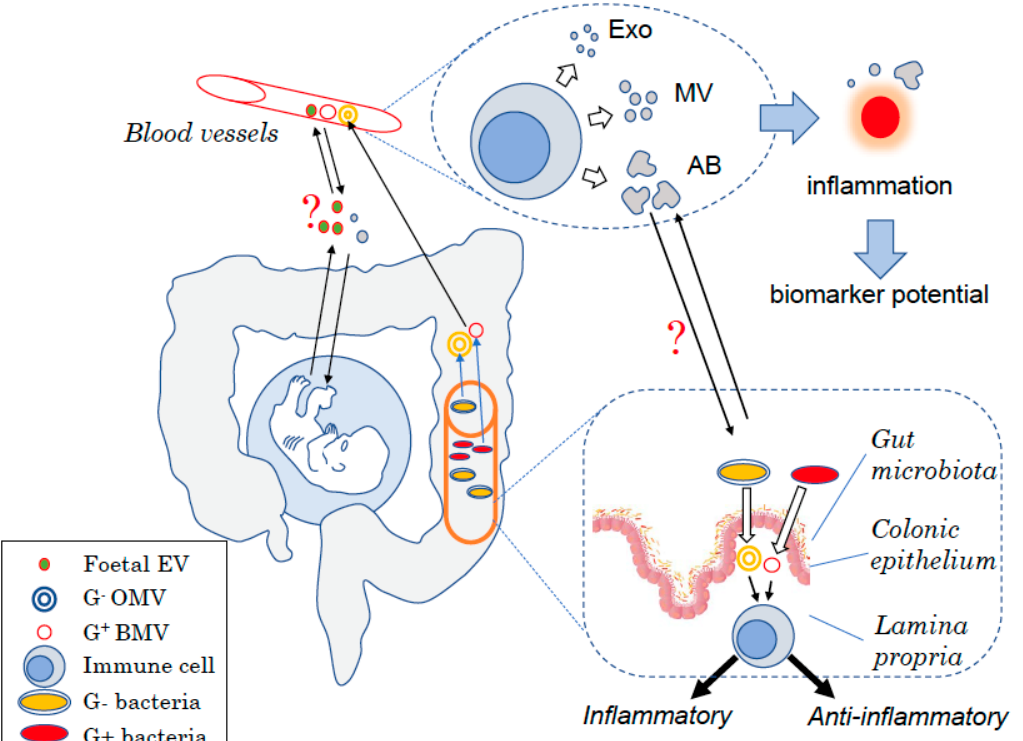
Figure 1. Schematic view of the different types of EVs in humans. EVs are produced at each body site such by mononuclear cells in the blood under the form of exosomes (Exo), microvesicles (MVs), or apoptotic bodies (AB) depending on their size. Changes in the amount of EVs produced have been linked to inflammatory diseases and thus could be used as biomarkers to diagnose diseases. EVs are also key for the host to communicate with endogenous yet “foreign” organisms. During embryonic development, the foetus produces EVs that can interact with cells from the mother and might interfere with maternal tolerance towards the haploidentical foetus. Similarly, the gut bacteria produce EVs that can modulate host–cell immune responses and more broadly the host health status. Bacterial EVs can have pro- or anti-inflammatory effects depending on the bacteria of origin. EVs may also be used for the host to communicate with these “foreign” organisms with maternal EVs that could potentially affect the foetus development as well as host EVs shown to modulate the bacteria composition.